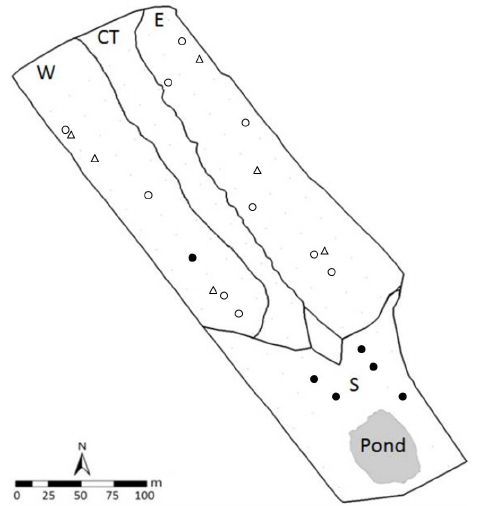
Figure 1. Map of Chicken Creek (W is the western section, CT is the central trench, E is the eastern section, S is the southern sec- tion with pond). Triangles indicate the sampling points used for BSi analyses at t 0 ( n = 6). Circles indicate the sampling points used for measurements of soil parameters (at t 0 and t 10 ) and plant analyses (only at t 10 ) (W, n = 5; E, n = 6; S, n = 5). Empty and filled cir- cles represent sampling points where Calamagrostis epigejos and Phragmites australis became dominant. Note that the size of sam- pling points is not to